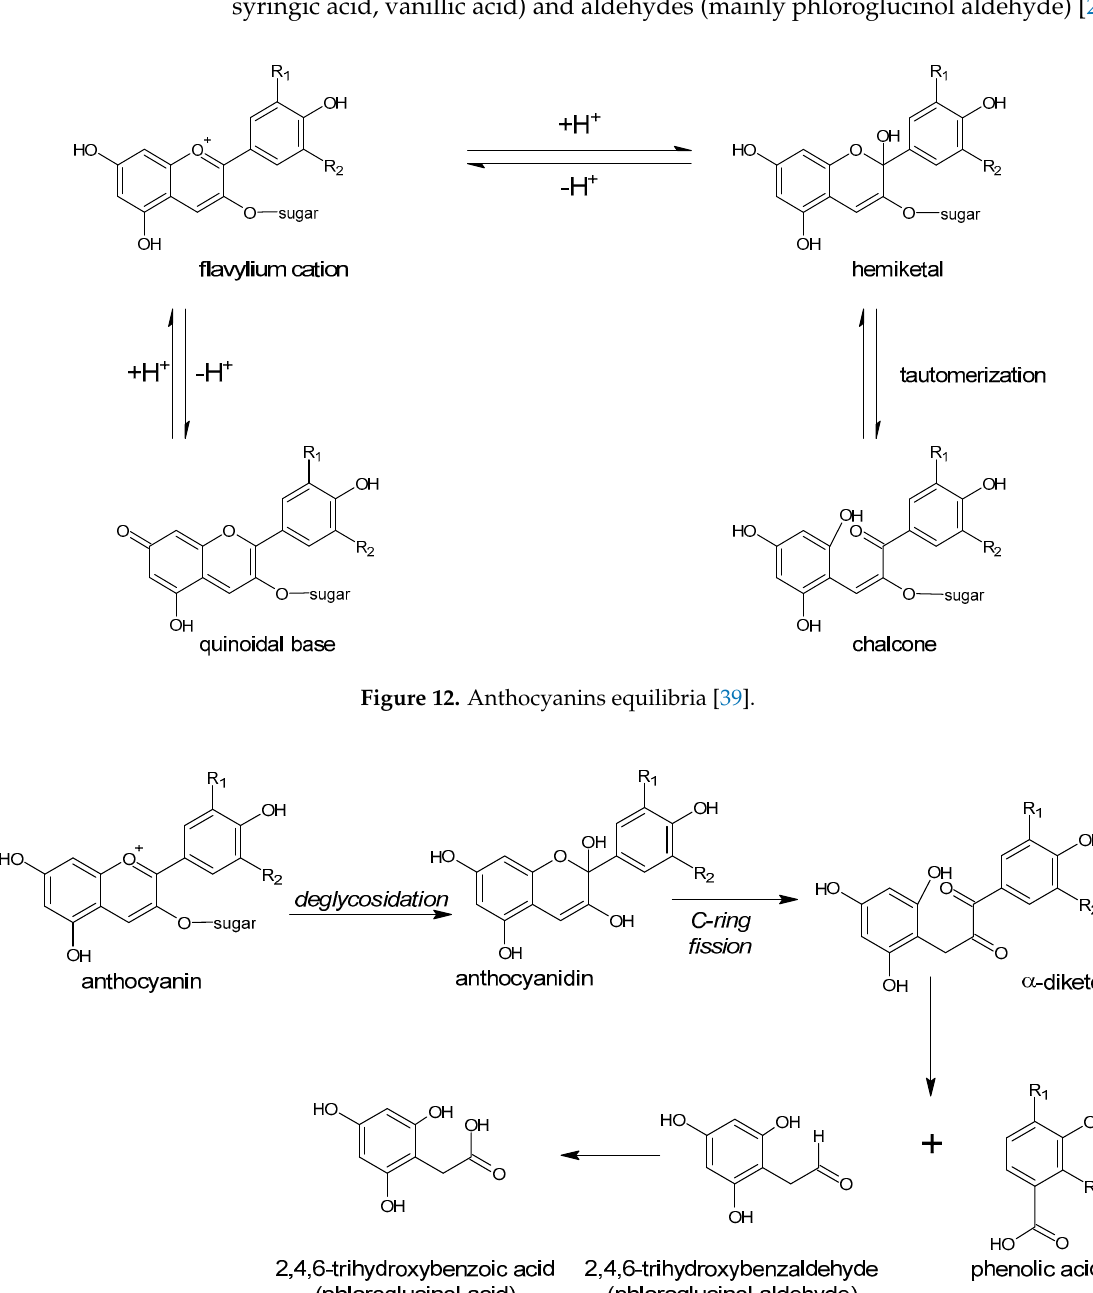
Figure 13. Main steps of anthocyanin degradation. Based on [274,282].